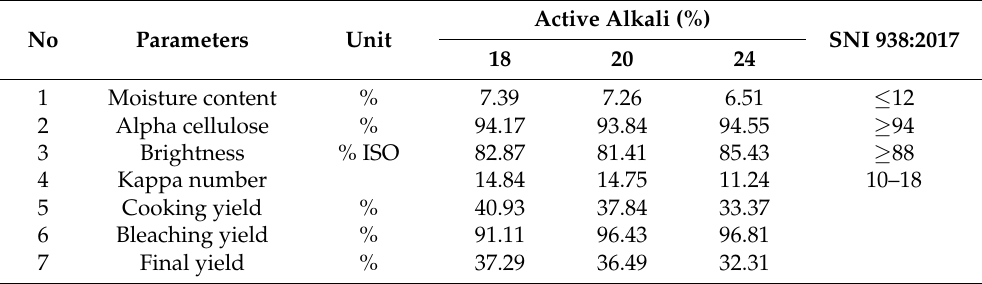
Table 7. Main analysis results of dissolving pulp (DP) from whole-empty fruit bunches